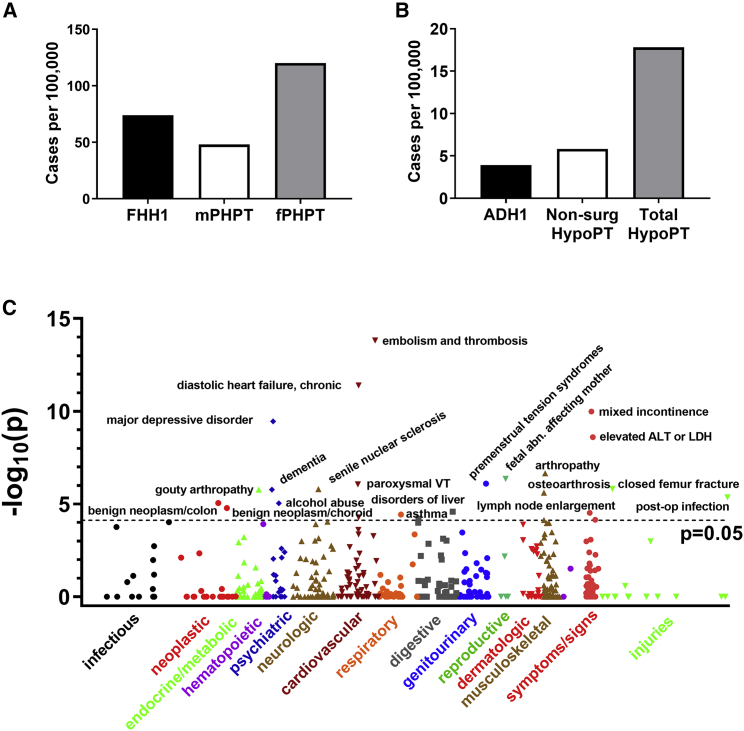
Prevalence of FHH1 and ADH1 in DiscovEHR Cohort(A) FHH1 prevalence in the DiscovEHR cohort (black bar) compared to the age-adjusted prevalence of male PHPT (mPHPT, white bar) and female PHPT (fPHPT, gray bar) cases reported in a large US cohort.14(B) ADH1 prevalence in the DiscovEHR cohort (black bar) compared with prevalence of non-surgical hypoparathyroidism (non-surg HypoPT, white bar) and all forms of hypoparathyroidism (Total HypoPT, gray bar), estimated for the entire insured adult US population.23(C) Manhattan plot of SKAT analysis used to detect disease associations defined by ICD9 codes for a binned group of all LoF plus mLoF variants. Labels indicate top associations with phenome-wide significance, which include all results above the dotted line, p < 0.05, corrected for multiple testing. Variants included in analysis and all significant results are in Table 4.